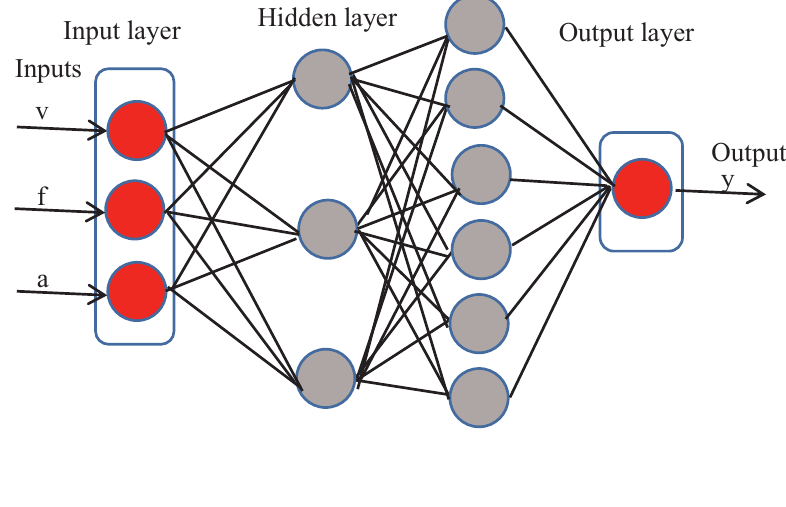
Fig. 1. A backpropagation neural